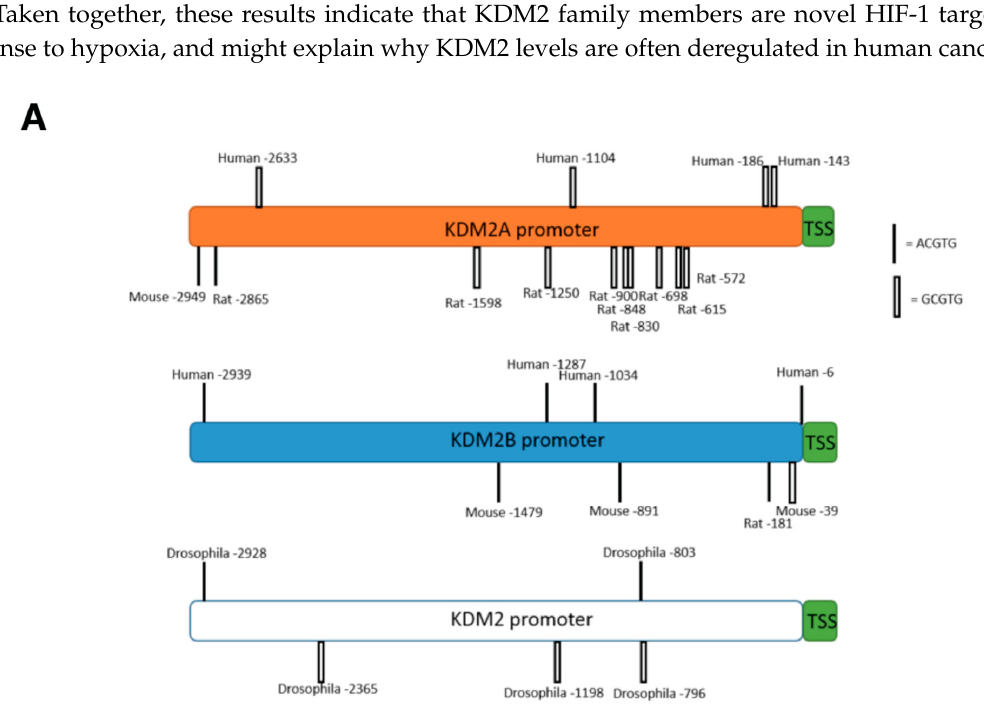
Figure 5. Figure 5. Cont.